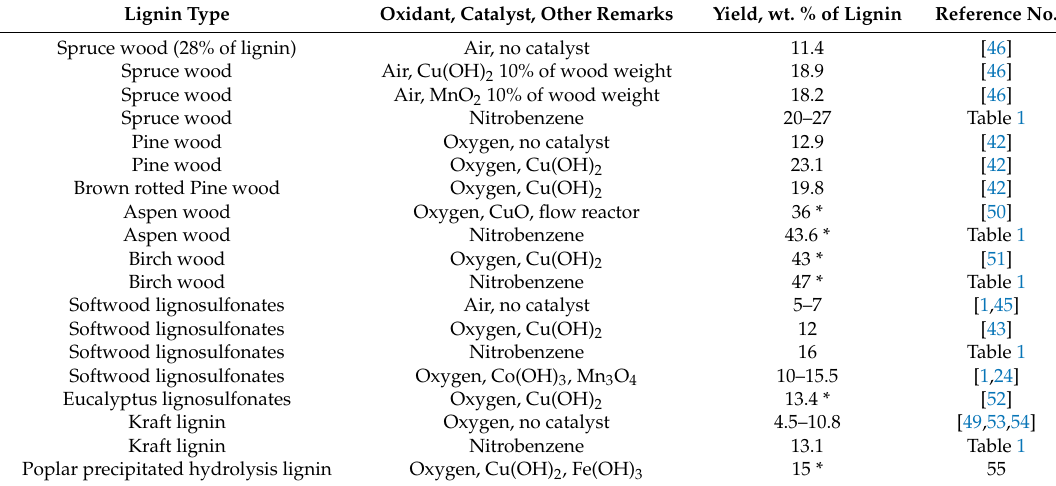
Table 2. Comparison of the aromatic aldehydes yield in oxidation of various lignins by molecular oxygen and nitrobenzene in alkaline media. Lignin Type